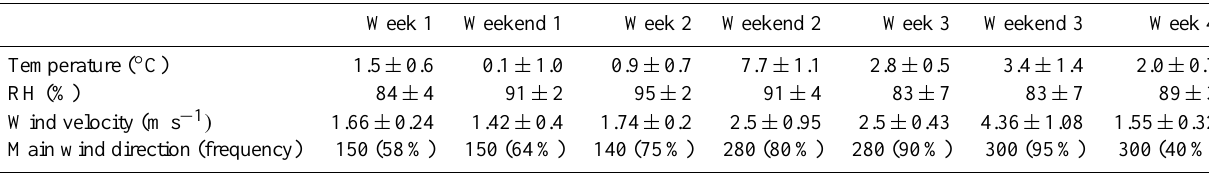
Table 2. Summary of the weather conditions (mean values ± 1 standard deviation) during each weekdays (Monday to Friday) and weekends